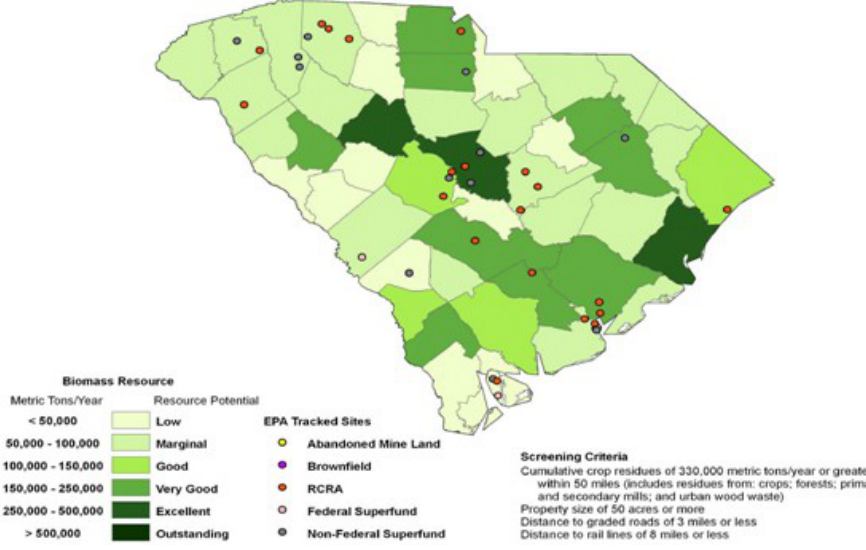
Figure 2. Candidate Harvesting Sites, Collection Facility, and